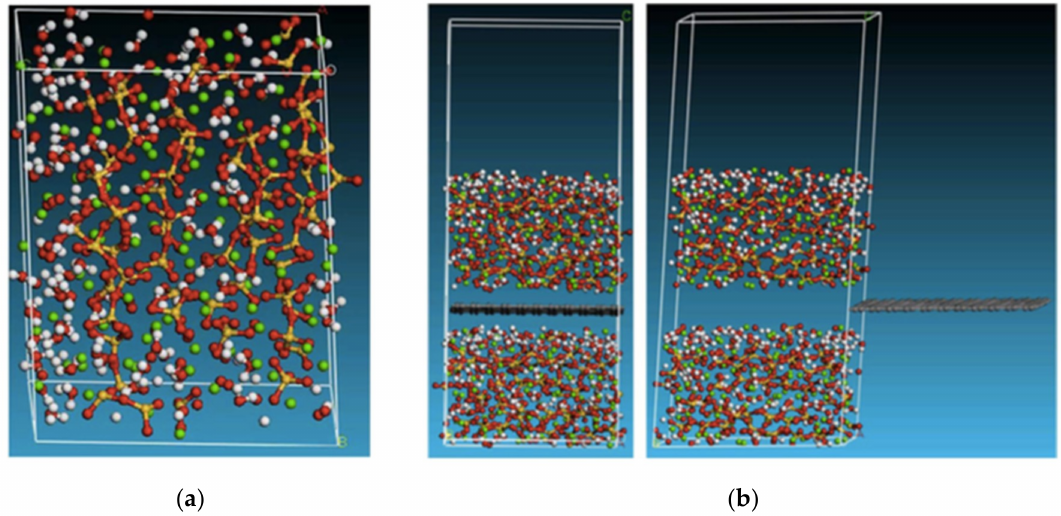
Figure 10. Atomic model for ( a ) calcium–silicate–hydrates (C–S–H) and ( b ) graphene C–S–H hybrid nanocomposite interfacial pullout. Reproduced from [103], with permission from American Society of Civil Engineers,